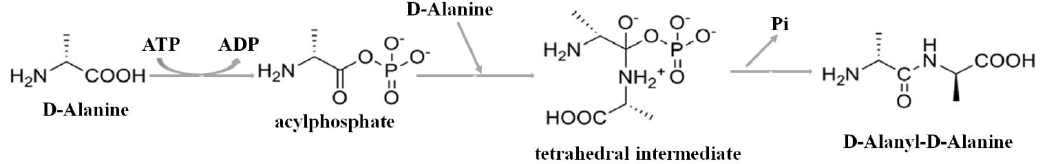
Figure 1. A series of chemical reactions catalyzed by DdlA.